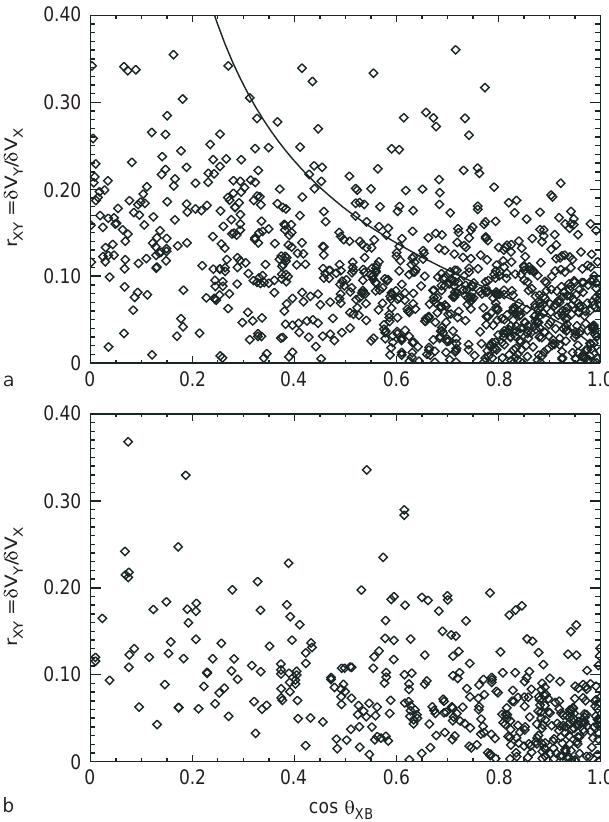
Fig. 3a, b. Scatter plot of the ratio r xy of the voltage di(cid:128)erences D V y and D V x measured respectively on the y and x antenna versus the cosine of the angle h xB between the magnetic field and the direction of the x -antenna a for wave packets; the solid line is a theoretical ratio (cid:22) r xy based on Eq. (5) for k L x = 1.1; b